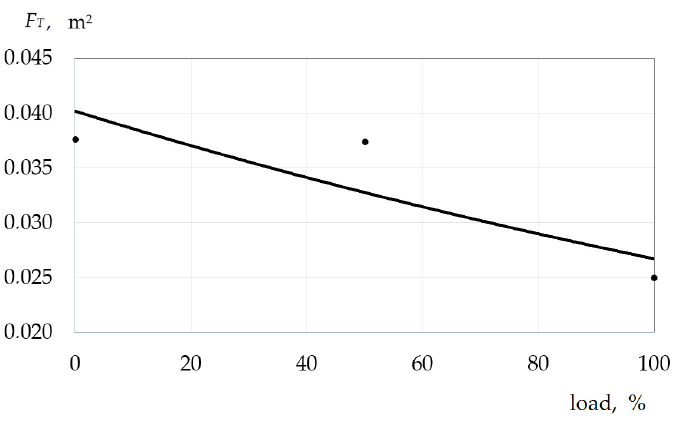
Figure 9. Dependence of the total throughput area along the tracts of one combustion chamber on the load value.